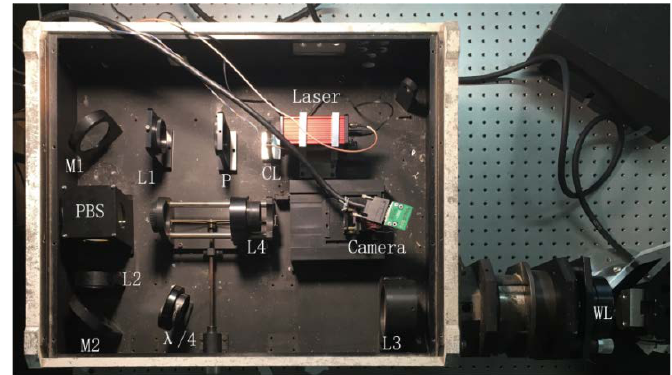
Figure 5. Layout of the optical path.